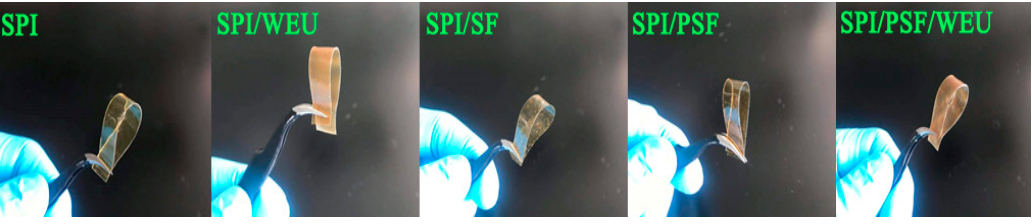
Scheme 2. The possible physical or chemical reactions generated in SPI-based film.